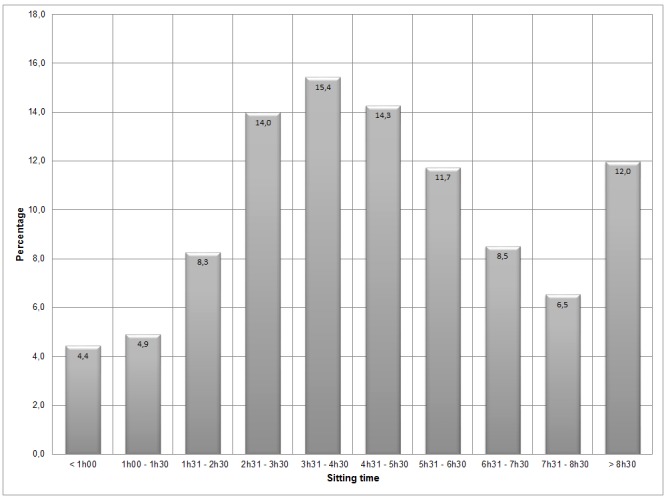
The distribution (%) of sitting time across the original response options, for all countries combined.